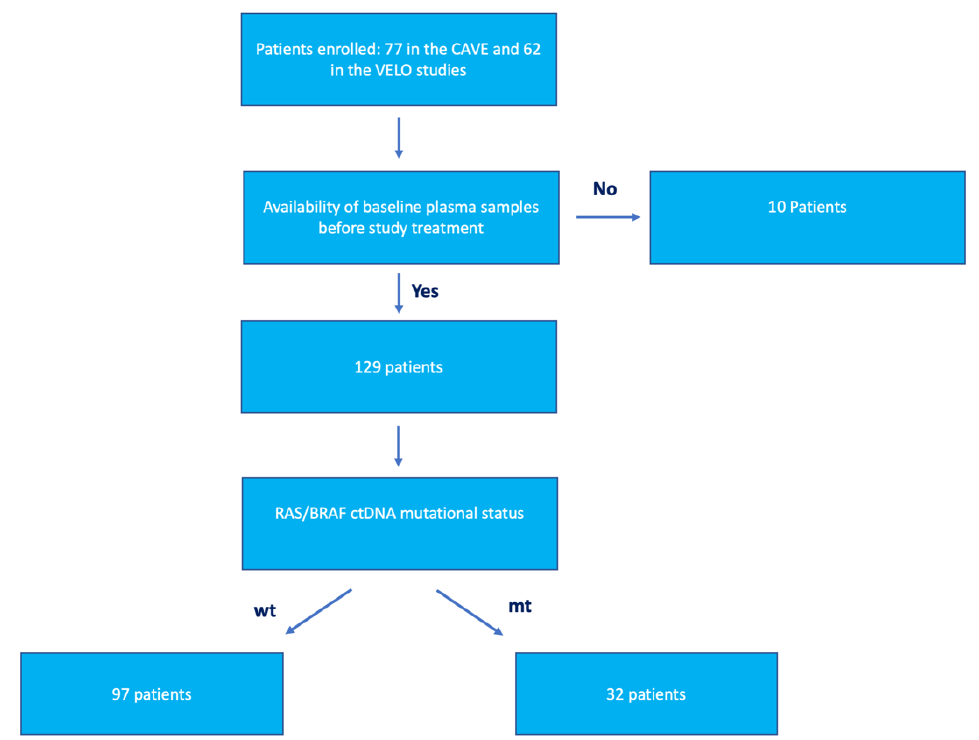
Figure 1. Patient selection flowchart. Of the 139 patients that had been enrolled in the CAVE and VELO clinical trials, 10 were excluded because their pretreatment plasma samples were not available. Of the 129 patients in the analysis, 97 had plasma circulating tumor DNA (ctDNA) RAS / BRAF wild type (WT), whereas 32 patients had plasma ctDNA RAS / BRAF mutations.